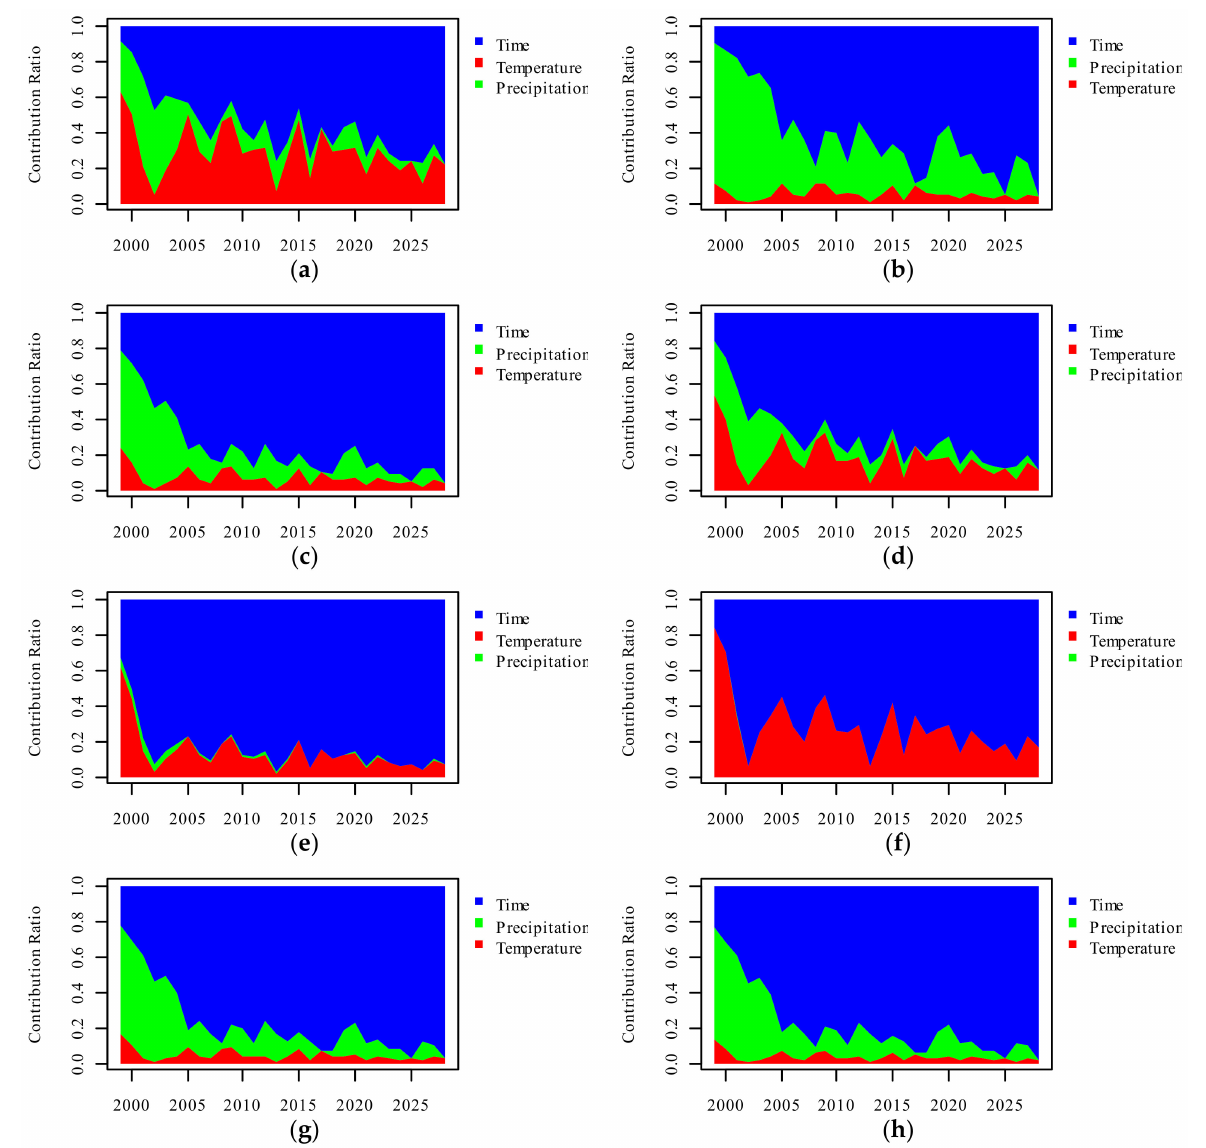
Figure 5. Contribution ratios of each environmental factors estimated after the turnover analysis on bird communities at the Molochna River valley over the period (1988–2018): the abscissa is the order of years, the ordinate axis is the contribution ratio; year (blue), precipitation (green) and temperature (red). ( a )—Agricultural lands, ( b )—Forest shelterbelts, ( c )—Meadows, ( d )—Reed beds, ( e )—Rural areas, ( f )—Salt marshes, ( g )—Steppe, ( h )—Forest